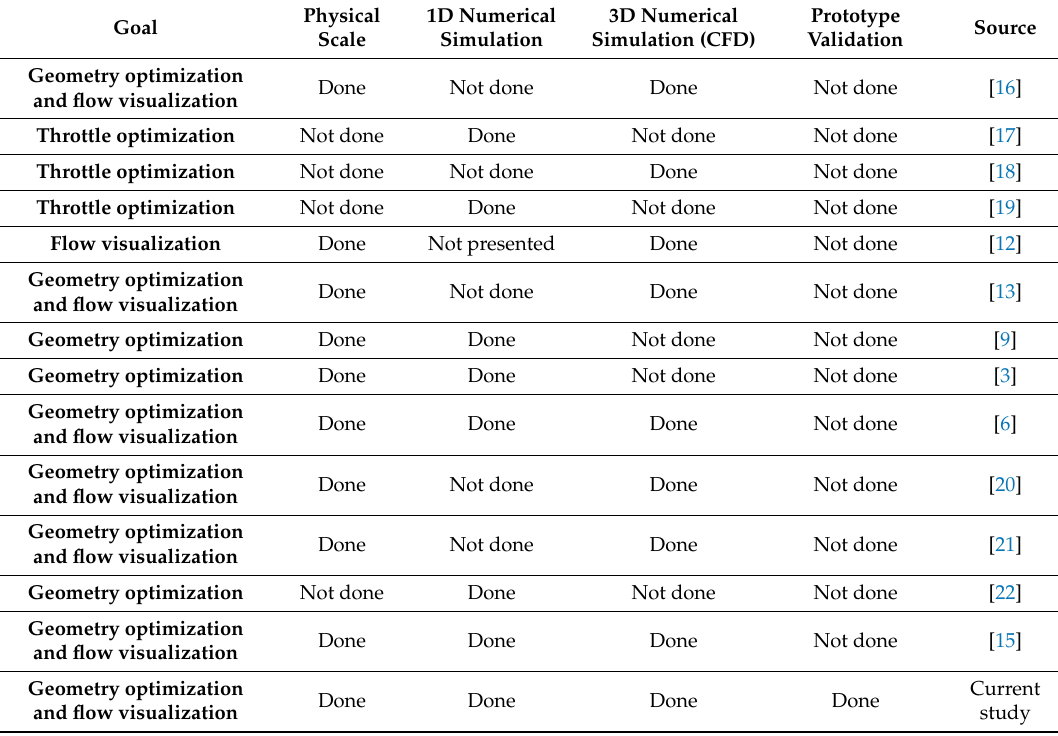
Table 1. Summary of existing studies on throttled surge tanks (extended from [2]).